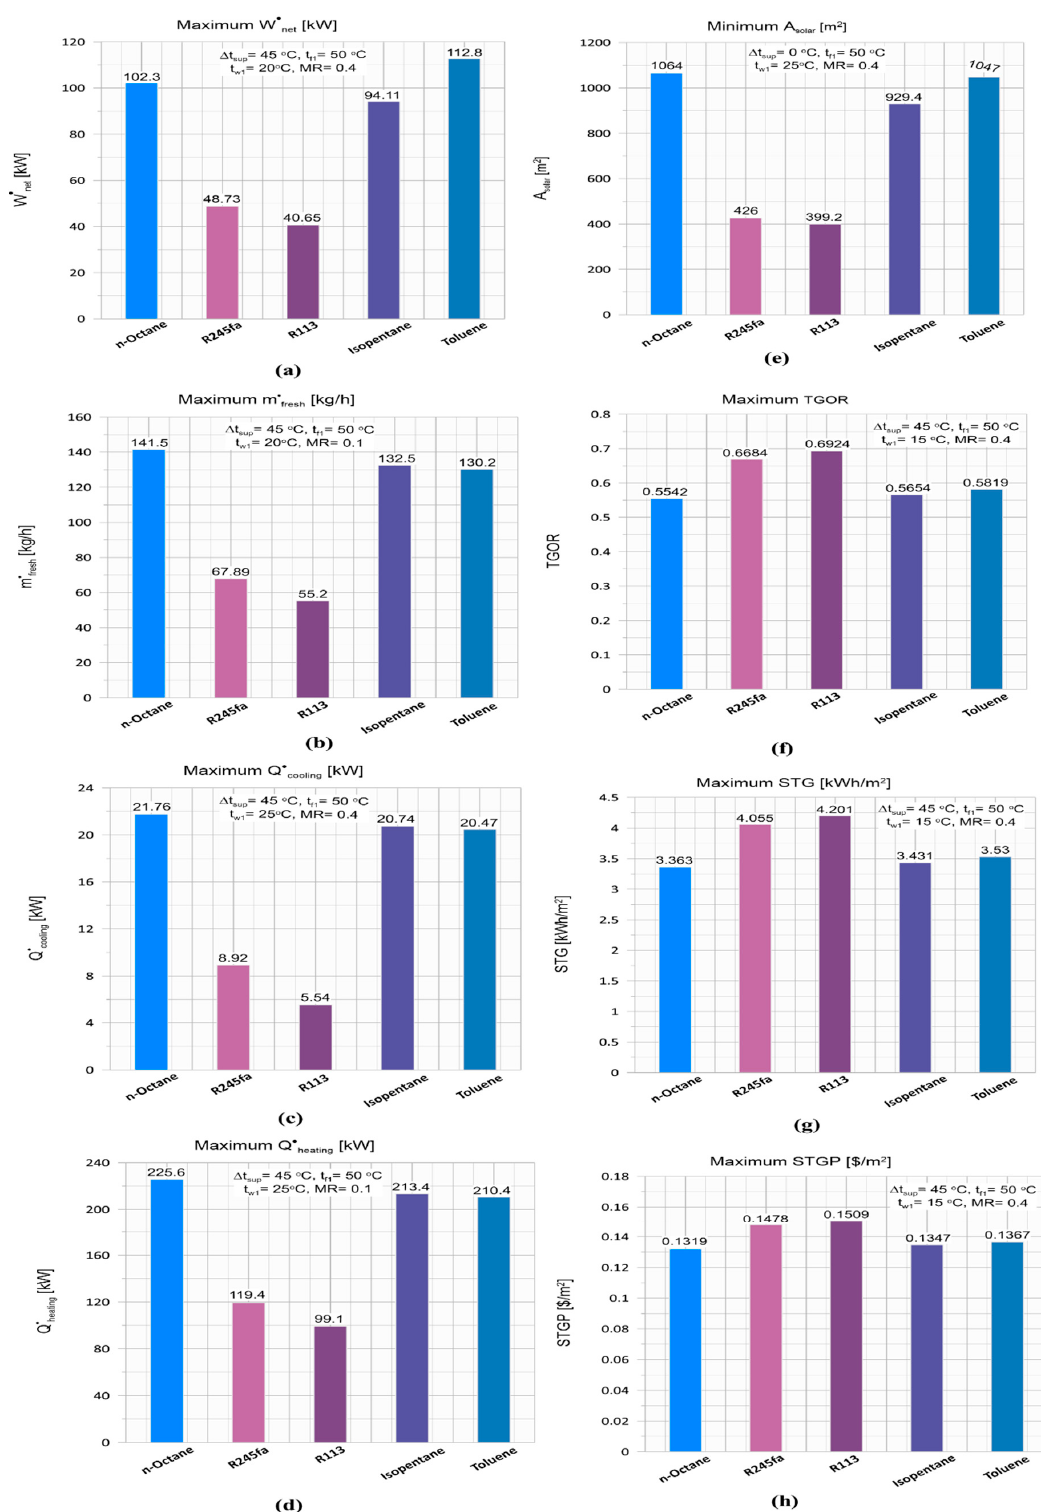
Figure 6. Comparisons of maximum proposed systems’ productivity and performance indicators for different ORC fluids: ( a ) 𝑊 (cid:3041)(cid:3032)(cid:3047)• ; ( b ) 𝑚 (cid:3033)(cid:3045)(cid:3032)(cid:3046)(cid:3035)• ; ( c ) 𝑄 (cid:3030)(cid:3042)(cid:3042)(cid:3039)(cid:3036)(cid:3041)(cid:3034)• ; ( d ) 𝑄 (cid:3035)(cid:3032)(cid:3028)(cid:3047)(cid:3036)(cid:3041)(cid:3034)• ; ( e ) A solar ; ( f ) TGOR; ( g ) STG; ( h ) STGP.